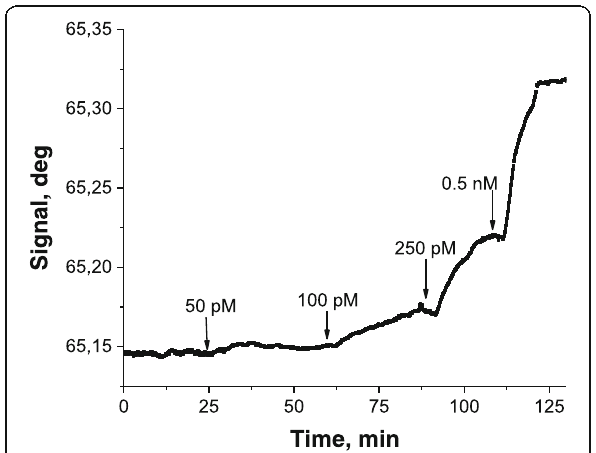
Fig. 2 The SPR sensogram obtained at the consecutive injections of various concentration of GNPs modified by the thiolated oligonucleotides T2-18m with the average number of 22 DNA strands per particle